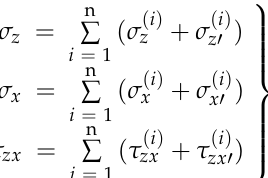
The total stress components of G ( x , z ) can then be expressed by Equation (4).